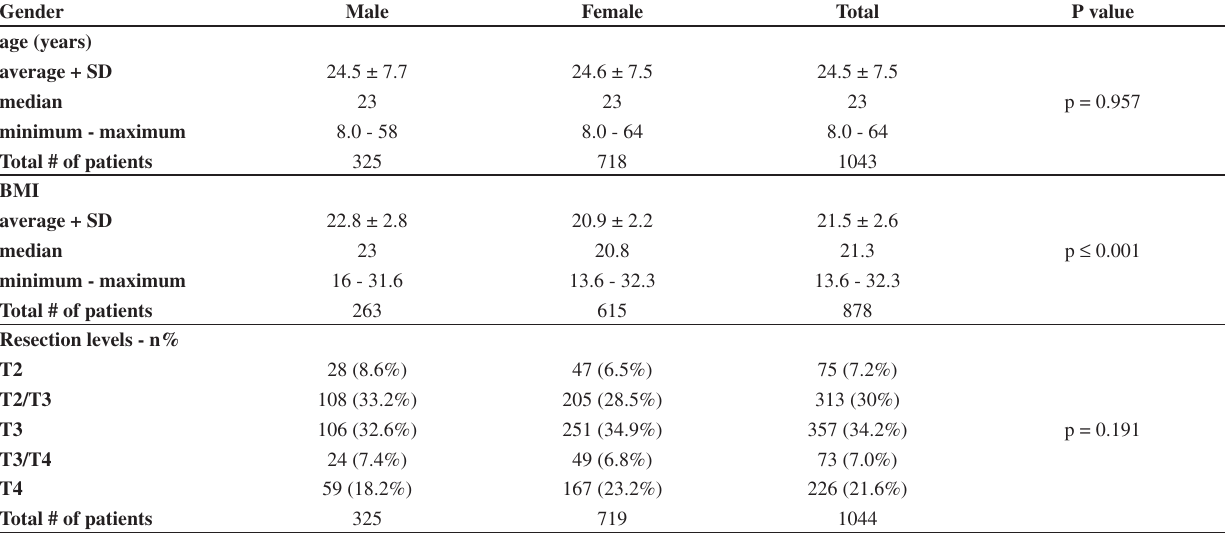
Table 1 - Descriptive analysis of each